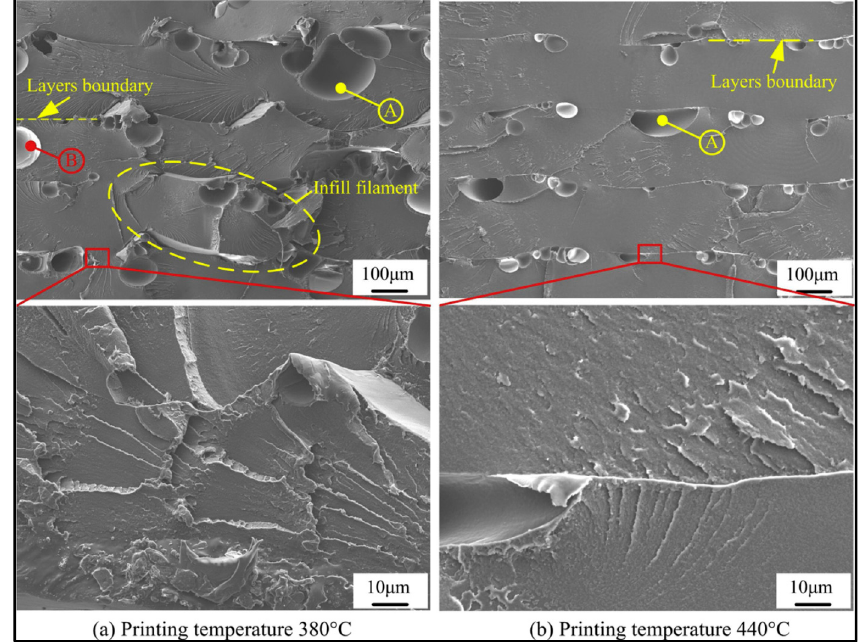
Figure 12. Representative SEM micrographs of the fracture surfaces of PEEK parts printed at different printing temperatures ( a ) at 380 ° C ( b ) at 440 ° C. A and B indicate voids between layers and a void between the infill filaments [84].